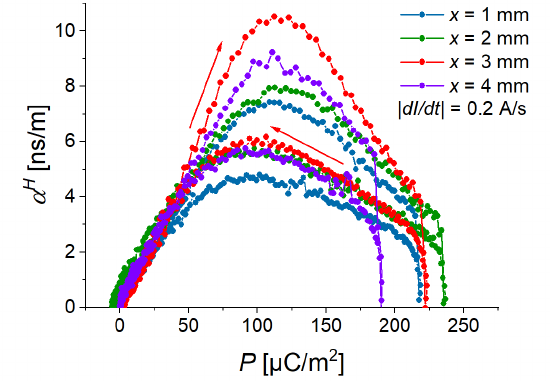
Figure 9. Dependences of ME coupling coefficient on electric polarization for different thicknesses of MAE layer and the magnetic slew rate of 12.2 kA/sm.